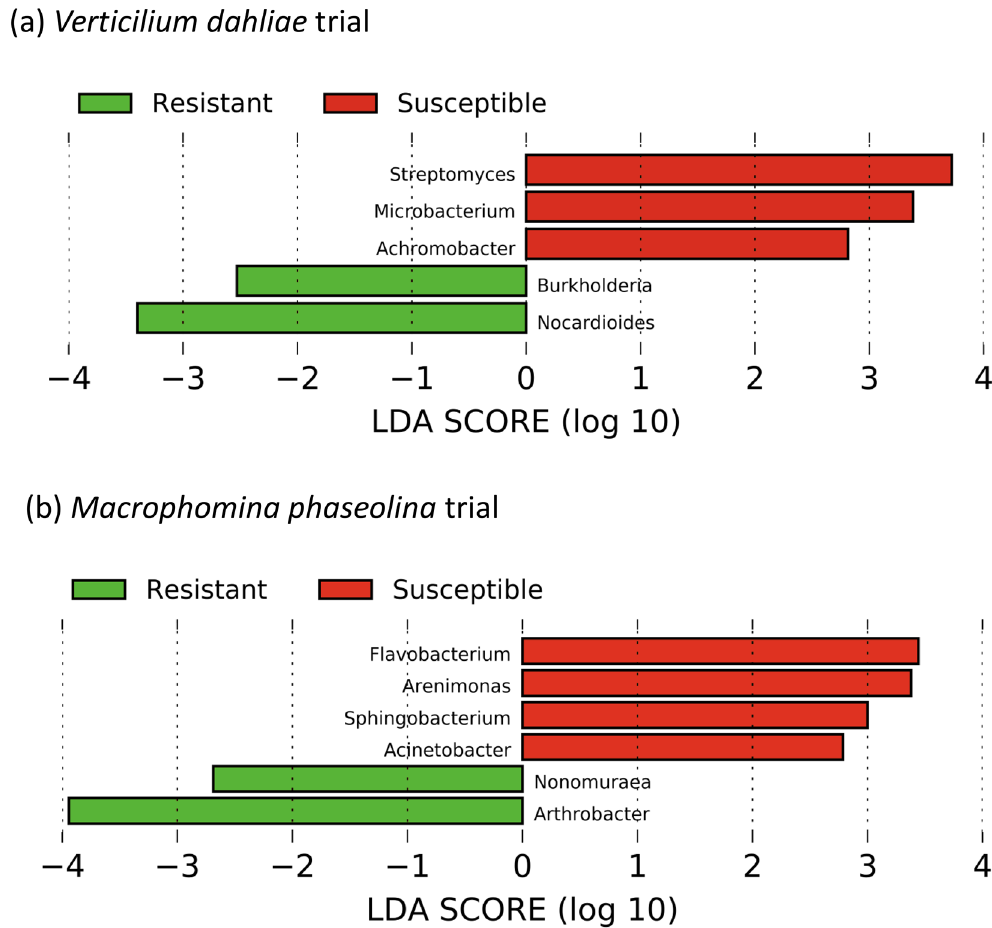
Figure 6. Linear discriminant analysis (LDA) effect size (LEfSe) showing the differential abundance of genera known to include species antagonistic to filamentous fungal pathogen in the rhizosphere of strawberry plants with high and low resistance against Verticillium dahliae ( a ) and Macrophomina phaseolina ( b ). Genera listed were significantly different (α = 0.05) and had an LEfSe score of > 2.0. A negative LDA score represents depletion in the rhizosphere of low resistance cultivars and enrichment in the rhizosphere of resistant cultivars (green) and a positive LDA score represents the opposite